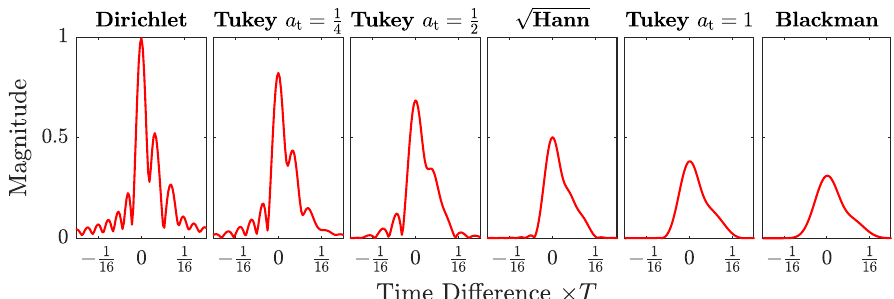
Figure 4. Autocorrelation magnitude comparison of a selection of shaping window functions. All magnitudes are normalized by the Dirichlet shaped chirp power for comparison. Gaussian noise was added to a signal-to-noise ratio SNR = 0dB, as well as two echoes at n = 9 and n = 19. To the left the spatial resolution and peak power is higher, to the right the inter-signal interference and spectral leakage are reduced.